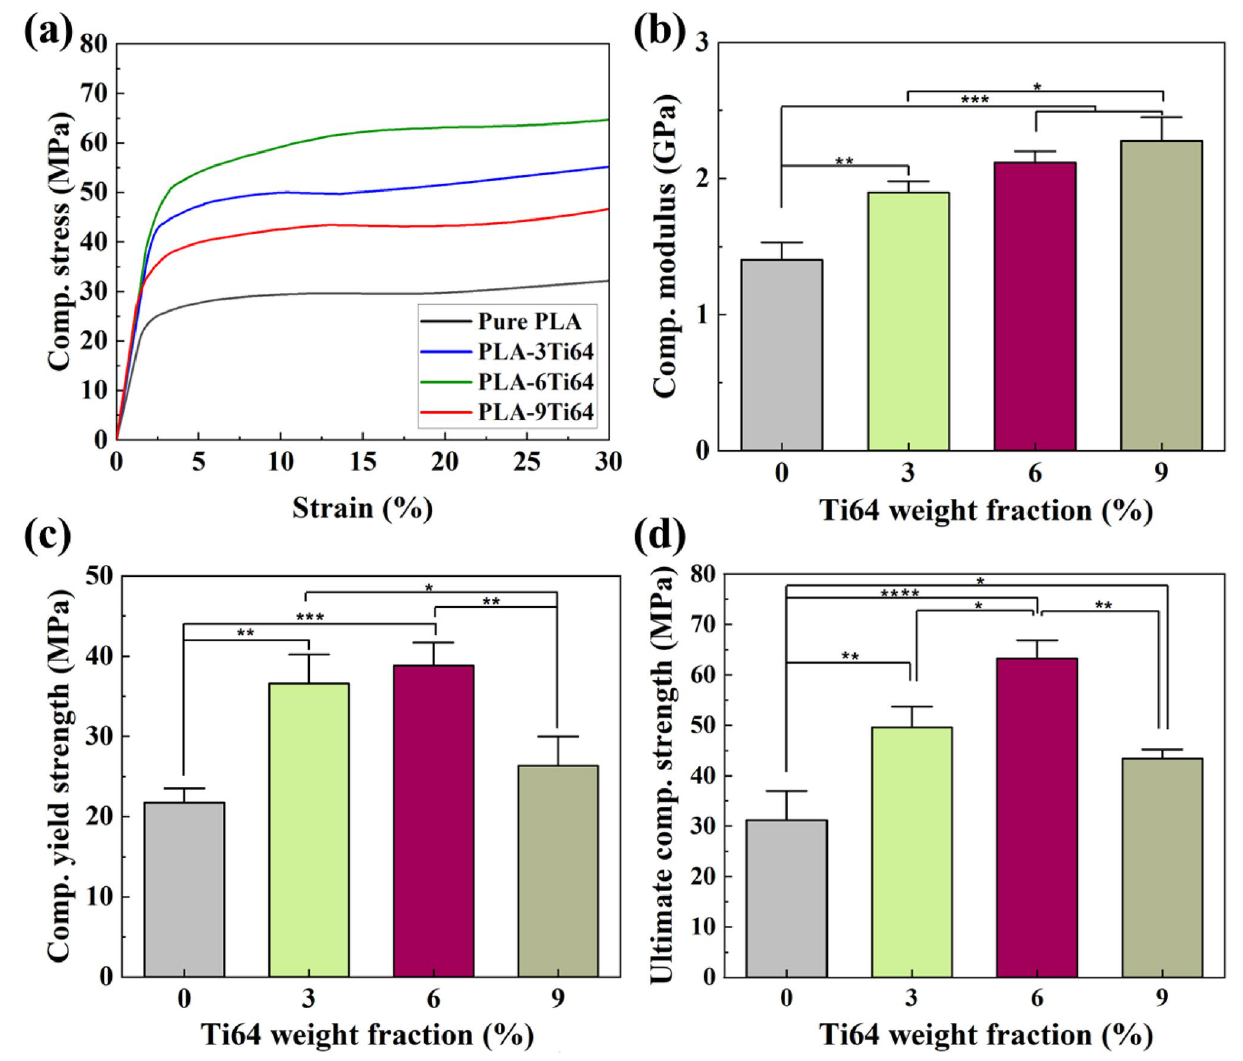
Figure 6. Compressive curves ( a ), compressive modulus ( b ), ultimate compressive strength ( c ), and elongation ( d ) of PLA-Ti64 composite scaffolds (* p < 0.05, ** p < 0.01, *** p < 0.001, **** p <